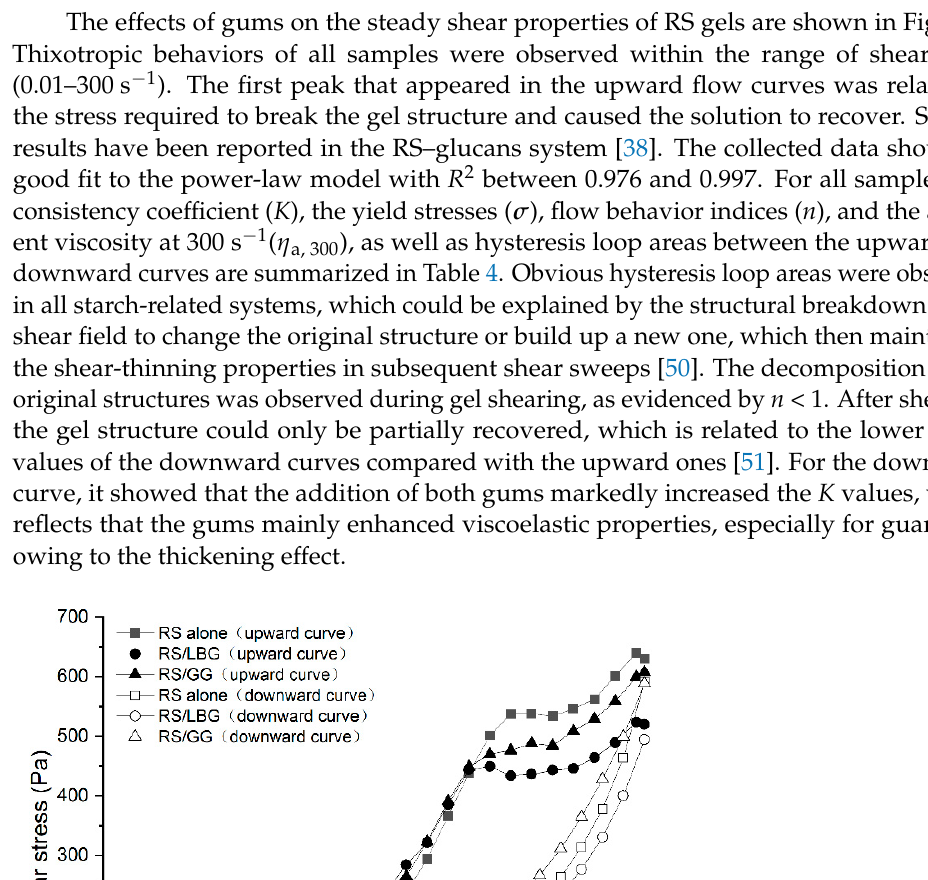
Table 4. The steady flow fitting parameters of RS alone, RS containing locust bean gum (RS/LBG), and RS containing guar gum (RS/GG) *.